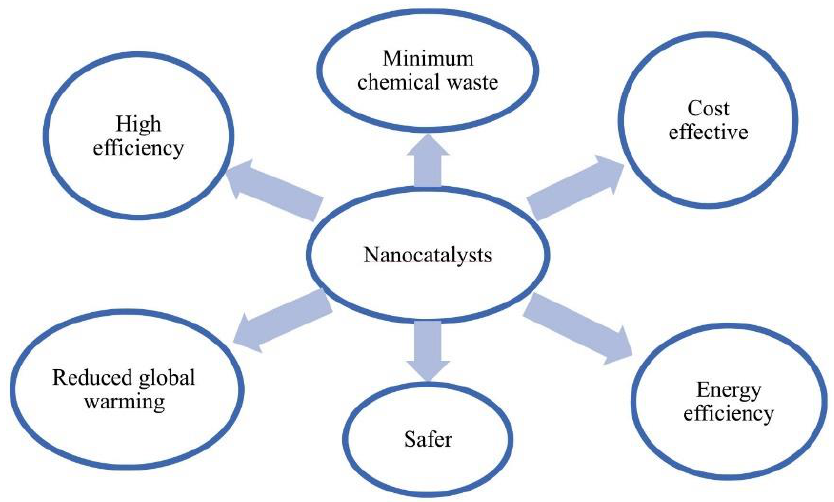
Figure 8. Main advantages of nanocatalysts. Data adapted from [143], published by Elsevier,